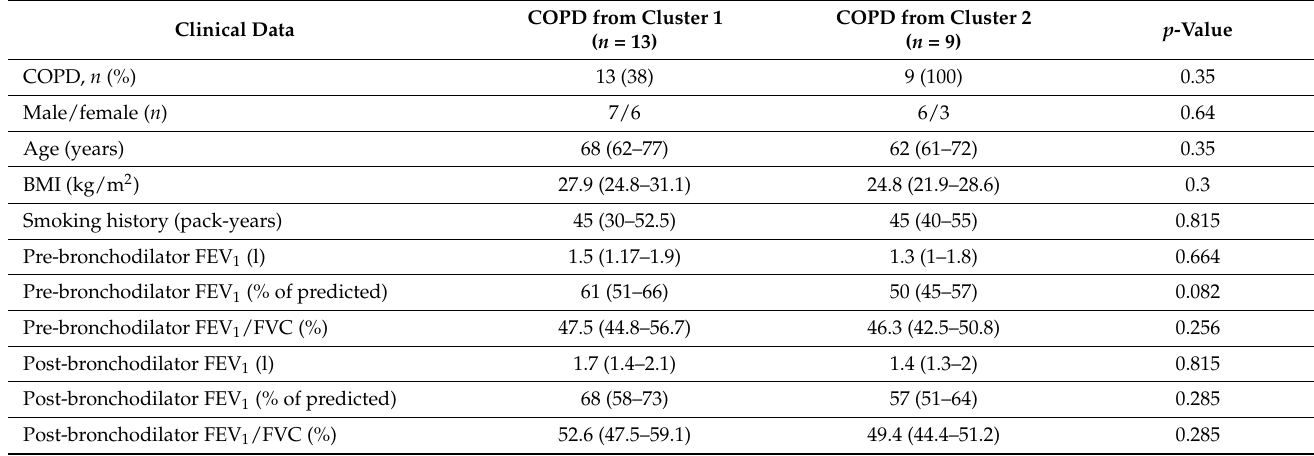
Table 6. Clinical characteristics of COPD patients in the two identified